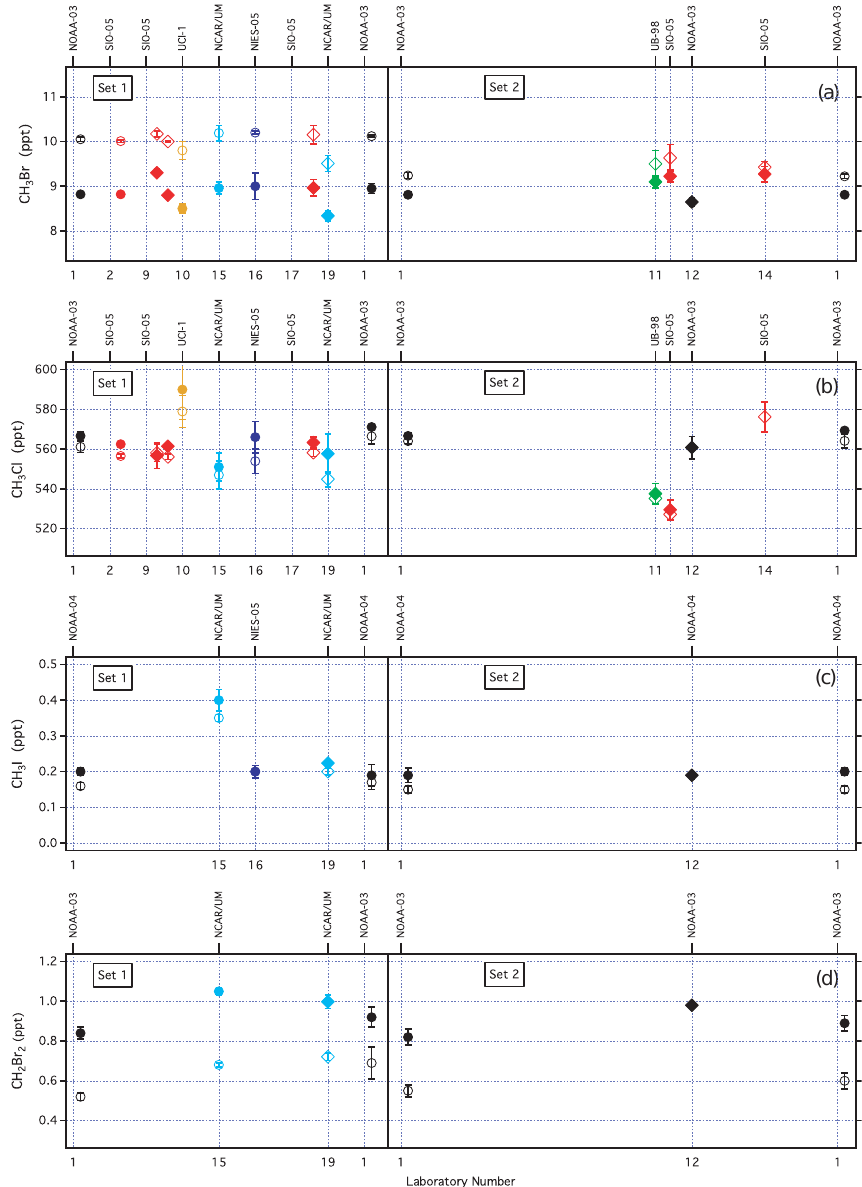
Fig. 5. Same as Fig. 1 for trace gases (a) CH 3 Br, (b) CH 3 Cl, (c) CH 3 I, (d) CH 2 Br 2